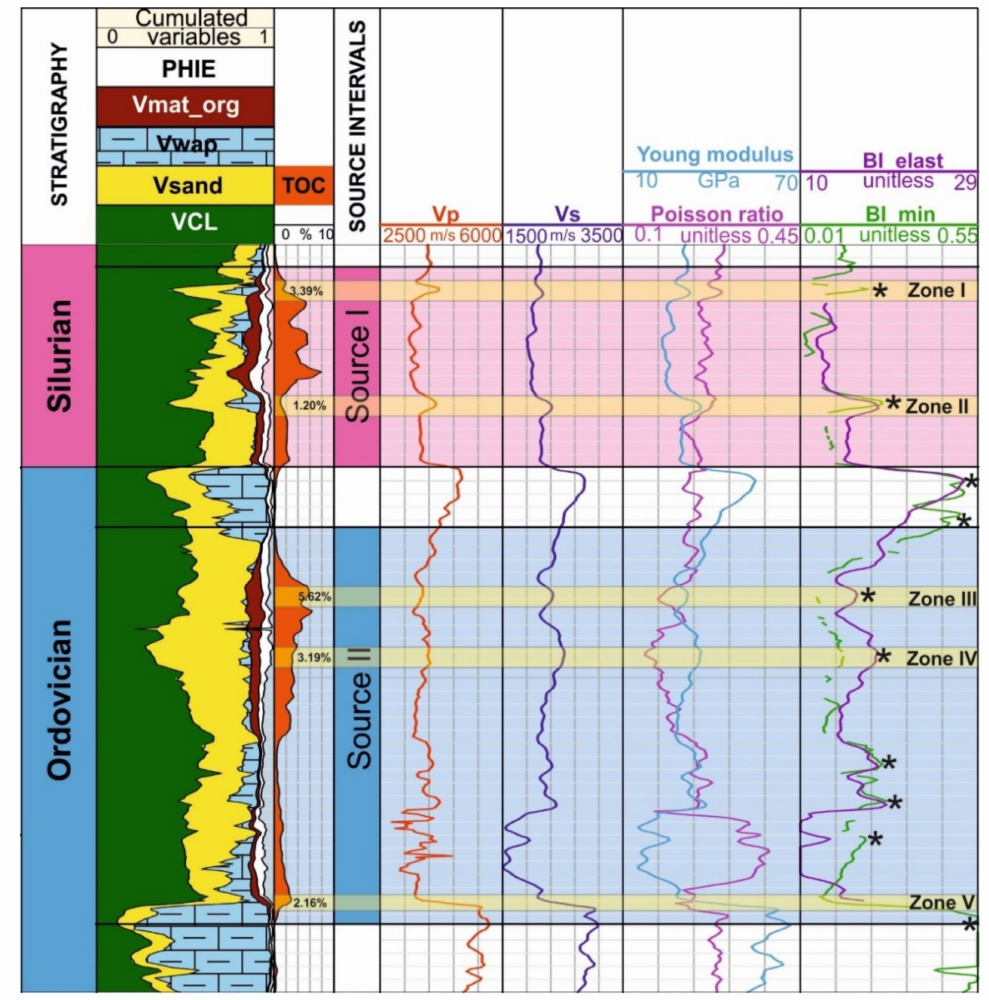
Figure 3. Estimated variation of BI according to the following model parameters: (1) stratigraphy, (2) rock model, (3) total organic carbon (TOC) content (wt. %), (4) source intervals, (5) compressional wave velocity ( V p), (6) shear wave velocity ( V s), (7) calculated elastic parameters (Young’s modulus and Poisson’s ratio), and (8) calculated brittleness index (BI) variants (BI elast and BI min ). Symbol * indicate zones (I–V) with the potentially high susceptibility for fracturing with the high TOC content at the same